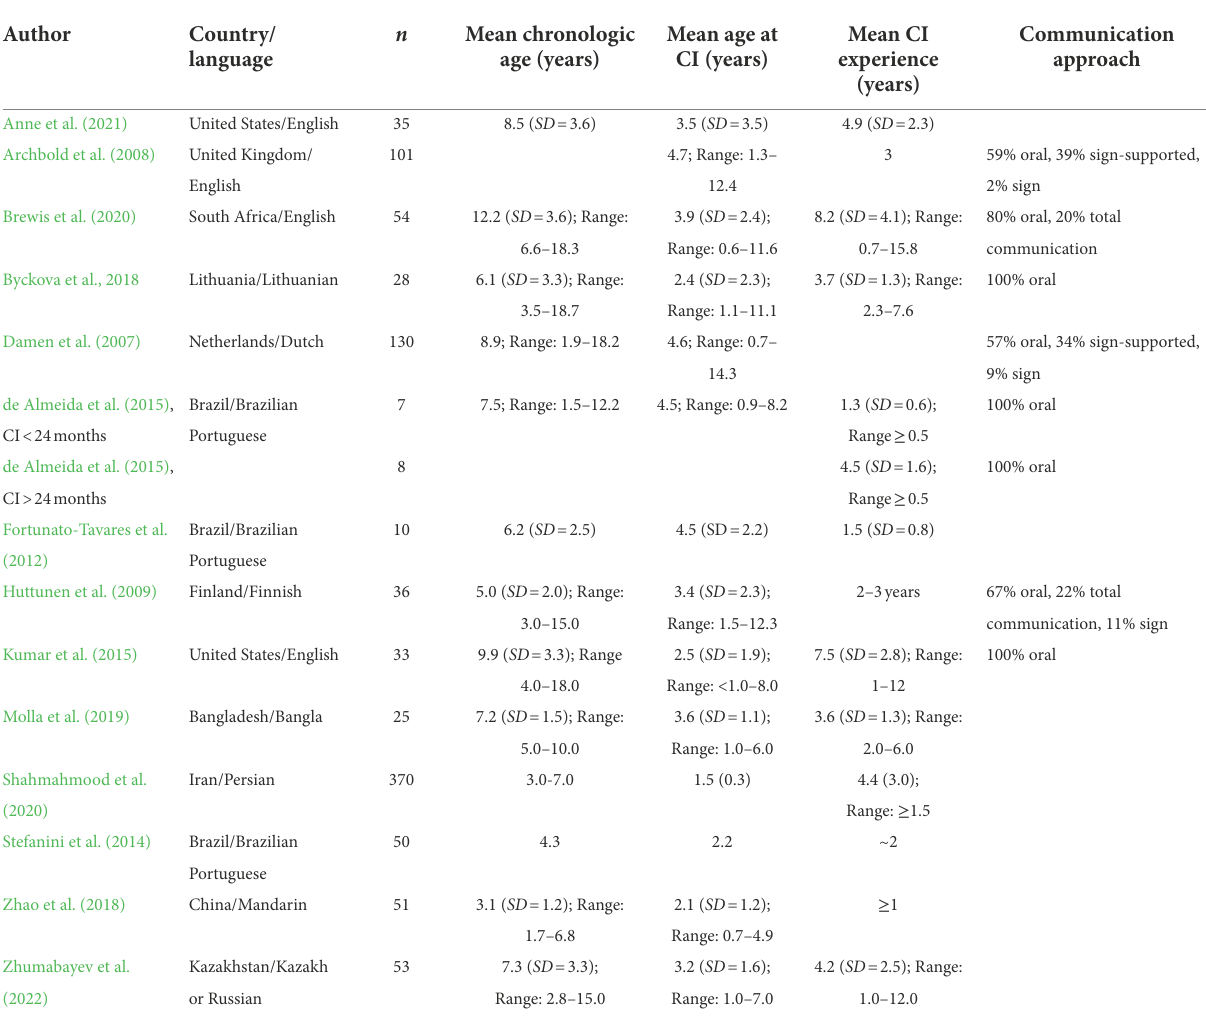
TABLE 1 Summary of articles included in the